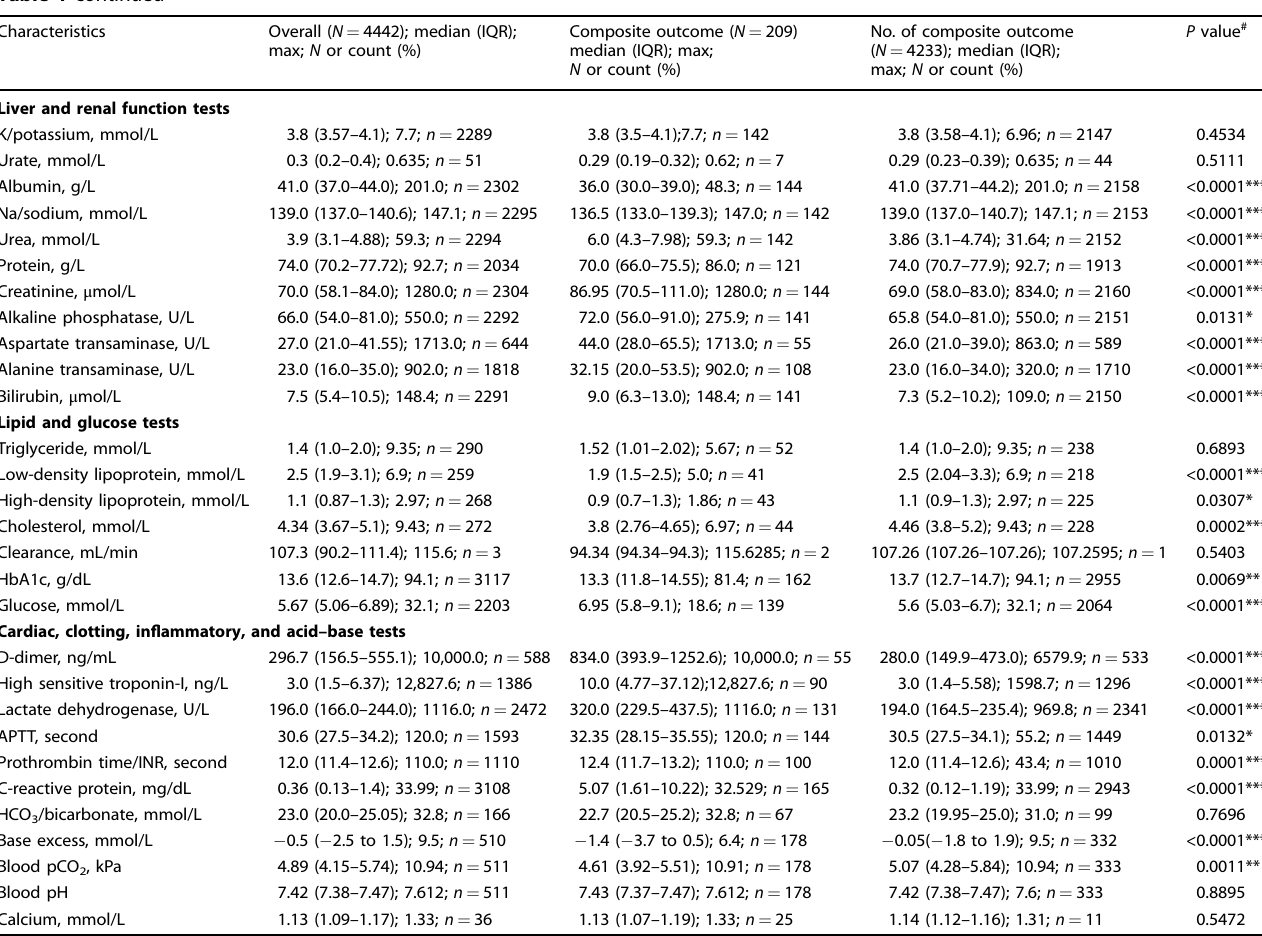
and clinical characteristics of male and female COVID-19 patients are provided in Supplementary Table 3. Development of a clinical risk score and validation Univariate logistic regression analyses are shown in Table 2, which identi fi ed the signi fi cant risk predictors for the composite outcome. However, for clinical practice, it is impractical to precisely input the values of all variables assessed from the different domains of the health records. Three different models were developed (Tables 3 – 5), as detailed in the “ Methods ” section. The easy-to-use score system is shown in Table 6. Patients meeting the primary outcome ( n = 212) have signi fi - cantly higher risk score (median: 5.13, 95% CI: 3.13 – 7.43, max: 18.6) than those who did not (median: 1.41, 95% CI: 0.65 – 5.94, max: 18.2) (Table 7), indicating the signi fi cant risk strati fi cation performance of the clinical risk score (OR: 17.1, 95% CI: 11 – 26.6) (Table 8). Survival curves strati fi ed by the dichotomized risk score are shown in Fig. 2, where yellow and blue curves represent the survival analysis for patients with a clinical risk score is larger and smaller than the cut-off, respectively.